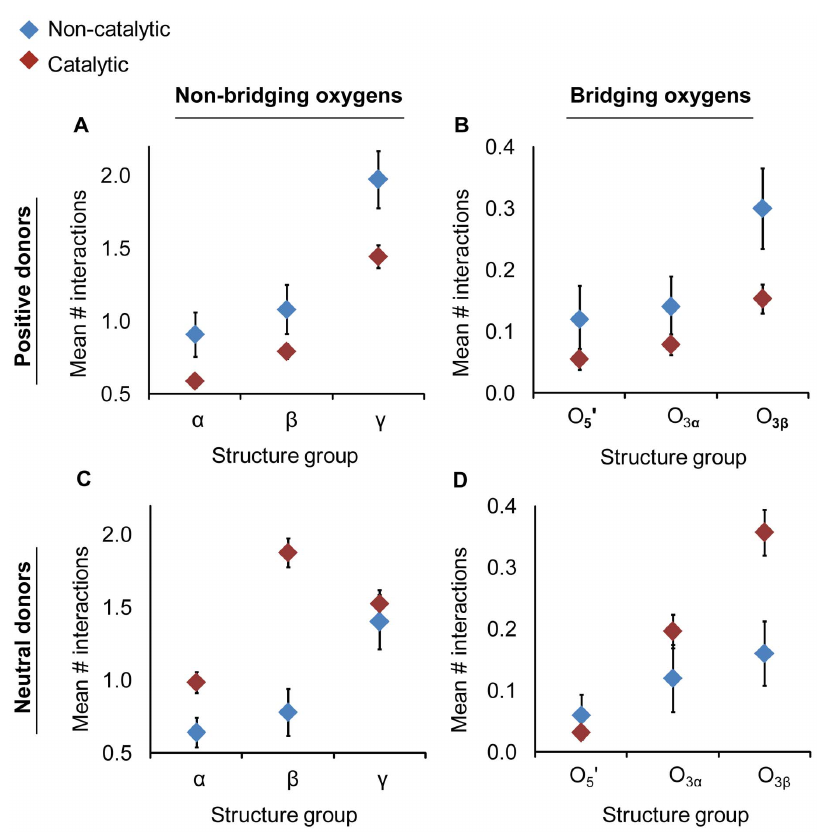
Figure 4. Non-catalytic (blue) active sites have a preference positively charged hydrogen bond donors (a–b) whereas in catalytic (red) active sites neutral interactions are favored (c–d). Mean numbers of hydrogen bonds were measured for non-bridging (a & c) and bridging (b & d) oxygens. The catalytic group is composed of both O 3 b —P c and P a —O 3 a structure sets. Positive donors include Lys, Arg, and His side chains and neutral donors include Asn, Gln, Trp, Ser Thr,Tyr, Cys side chains, the nucleotide O2 9 and O3 9 oxygens and all backbone nitrogens (except Pro).